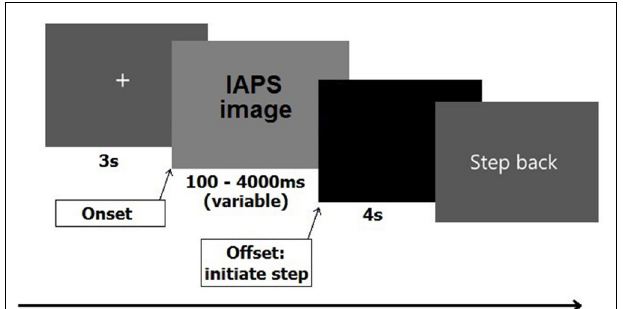
FIGURE 1 | Sequence of stimulus events for one trial.